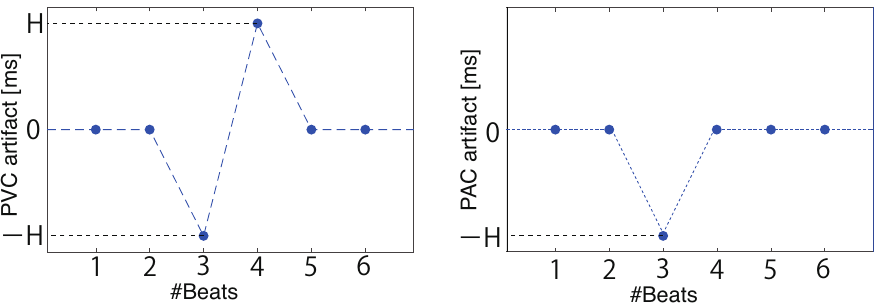
Figure 6. Artificial noise for generating PVC ( left ) and PAC ( right ), which was added at random points in the RRI data. The peak height of H was randomly set as 100 ms < H < 370 in this